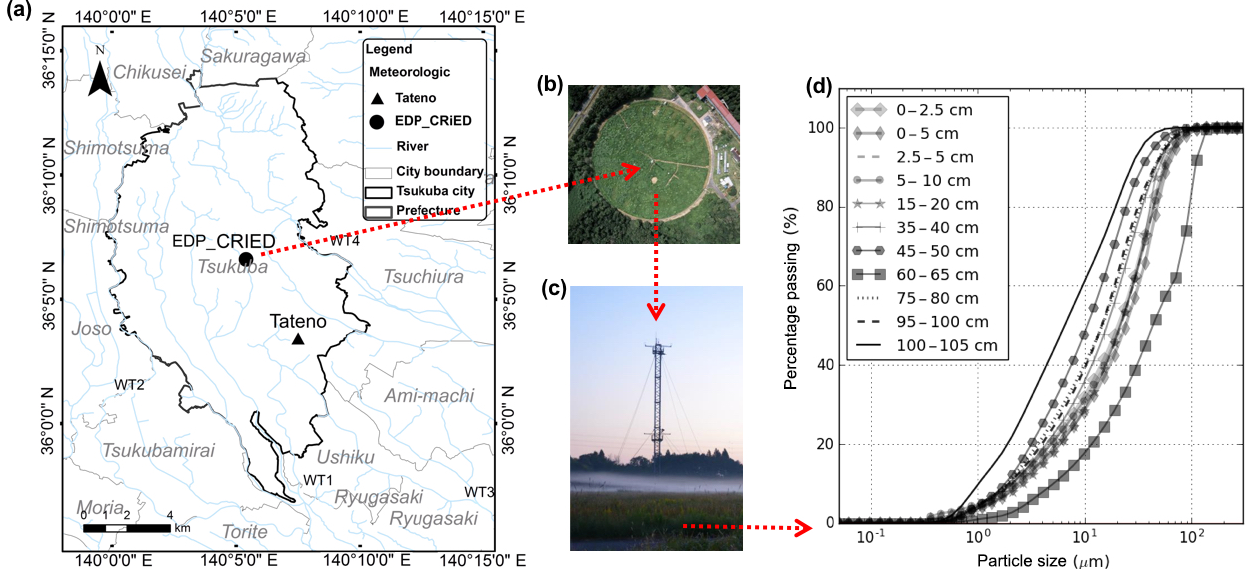
Figure 1. EDP observational site: (a) location, (b) projected view of the EDP grassland, (c) the observation tower and (d) results of the soil content